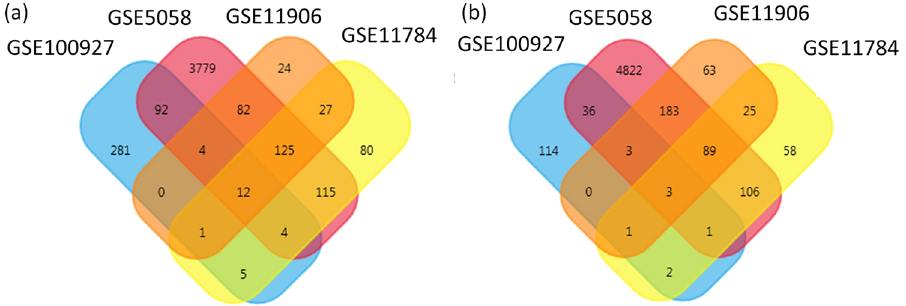
Figure 11: Venn diagrams with common DEGs from the GSE5058, GSE11784, GSE11906, and GSE100927 datasets: ( a ) upregulated DEGs and ( b ) downregulated DEGs.